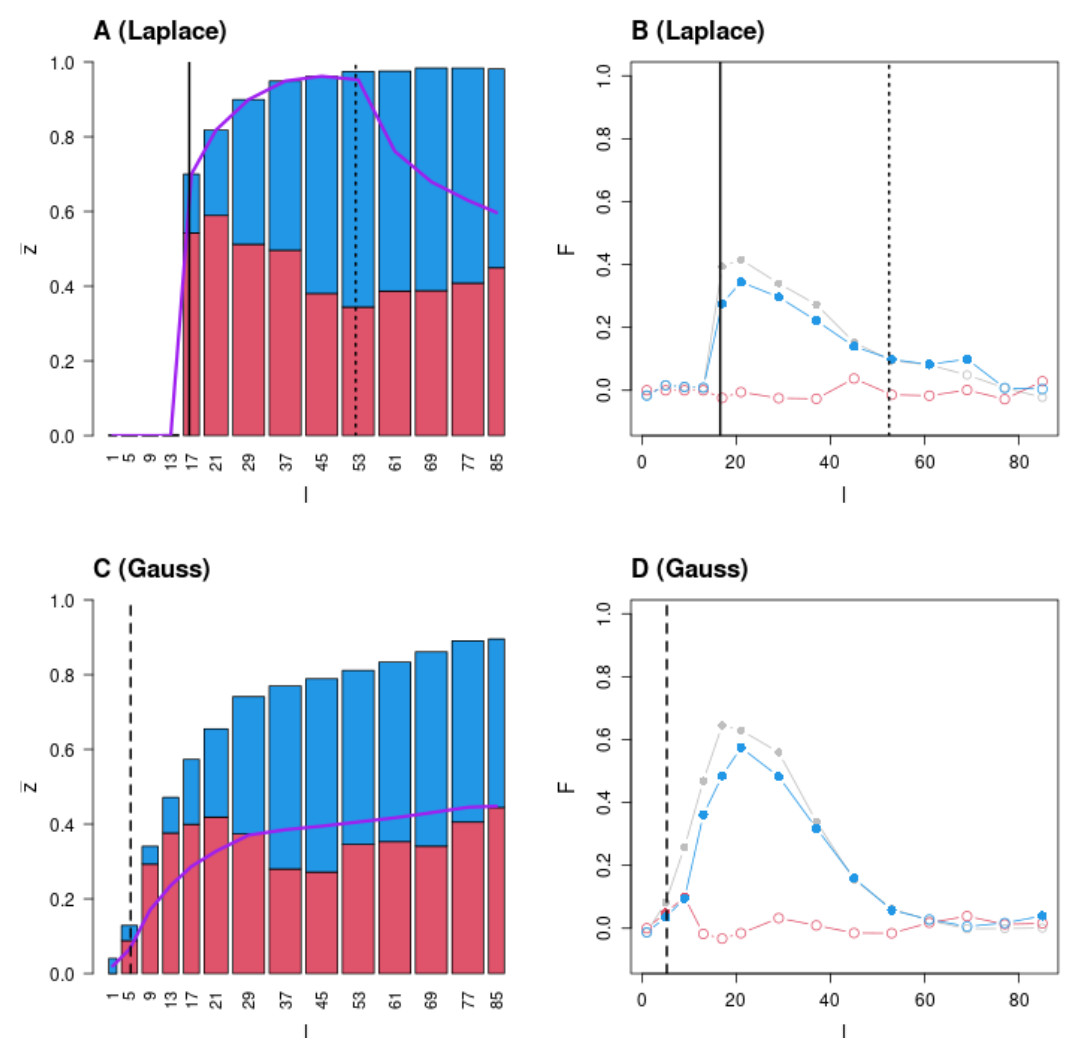
Figure 5 - Short-term genetic architecture of local adaptation after the emergence phase. Composition and structure of adaptive genotypes at the center of habitat 2 after the initial phase of adaptation (see methods) for Laplace (panels A and B) and Gauss (panels C and D) fitness trade-off. Panels A and C present the average phenotype (bars) at the middle of habitat 2 for various sizes of habitat 2 ( 𝑙 ), averaged over 20 replicates. The average relative contribution of alleles with large and small effects are presented in red and blue within each bar, respectively. The purple line shows the expected contribution of large versus small effects computed when rare at emergence (see eq. 17 and 18 of main text). In panel A and B (Laplace fitness function), vertical black lines show the analytical invasion thresholds above which a small (dotted line) or a large (solid line) effect mutation can invade alone the z *=0 resident phenotype ( l L ( a ) and l L ( A ) in main text, respectively). In panel C and D (Gauss fitness function), the vertical black dashed line show the analytical invasion threshold above which a small or large mutation can invade alone the z *=0 resident phenotype ( l G in main text). Panels B and D present the average aggregation of adaptive alleles along the genetic map at the middle of habitat 2 for various sizes of habitat 2 ( 𝑙 ), averaged over 20 replicates. Aggregation of all the adaptive alleles, small effects only and large effects only are presented in grey, blue and red, respectively. Filled dots correspond to significant F values, based on Bonferroni – corrected tests with 5% family-wise error